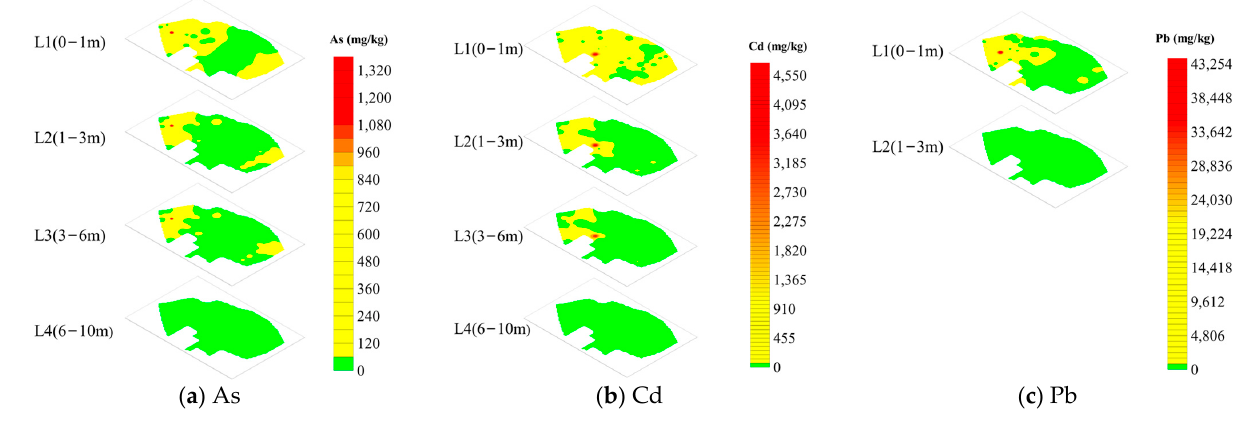
Figure 4. Distribution of soil heavy metal pollution in the study area. ( a ) Spatial distribution of As concentration. ( b ) Spatial distribution of Cd concentration. ( c ) Spatial distribution of Pb concentration.